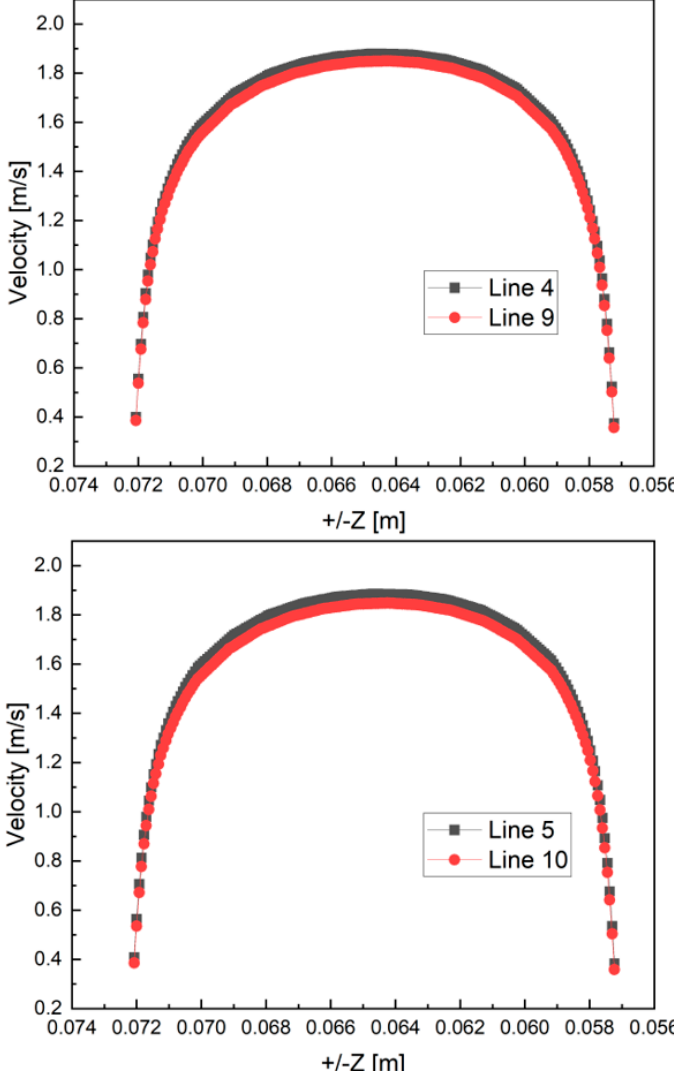
Figure 13. Velocity profile at lines 4 vs. 9 and 5 vs. 10.